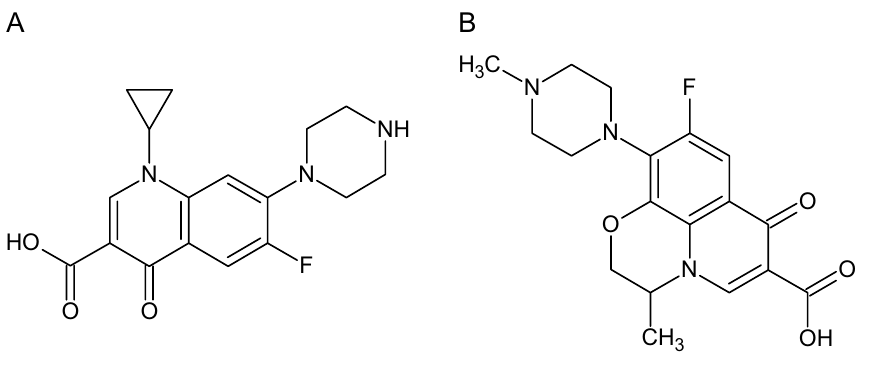
Figure 1. Structures of ( A ) ciprofloxacin, ( B )